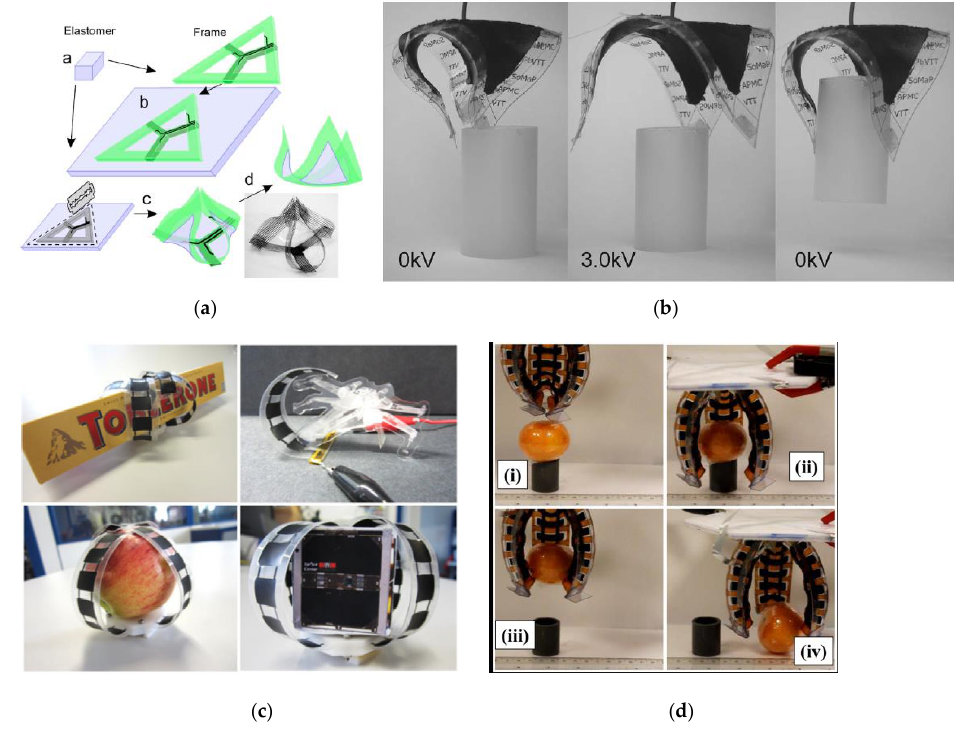
Figure 7. DE gripper based on dielectric elastomer minimum energy structure (DEMES): ( a ) Fabrication and working mechanism of DEMES [79]; ( b ) Grasping objects using DEMES gripper [79]; ( c ) multisegment DEMES gripper [82]; ( d ) multisegment DEMES gripper with arch flexure [83].